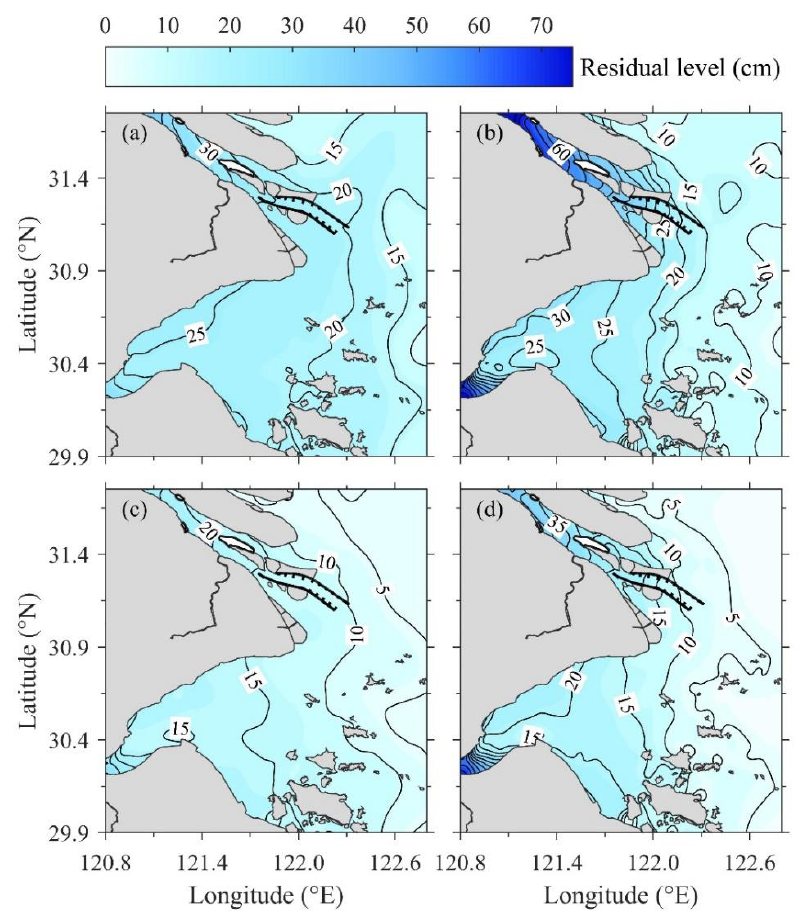
Figure 7. Distribution of residual water level during neap tide (left panel) and spring tide (right panel) in summer ( a , b ) and winter ( c , d ).